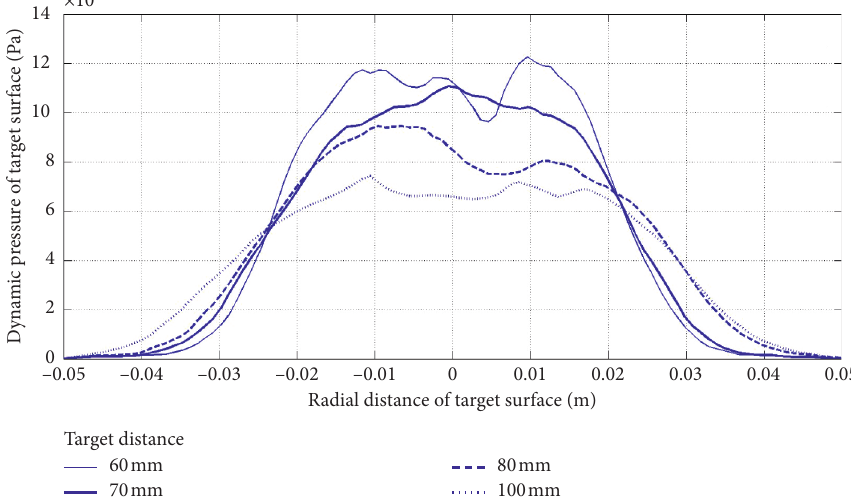
Figure 7: Radial dynamic pressure curve of target surface at different target